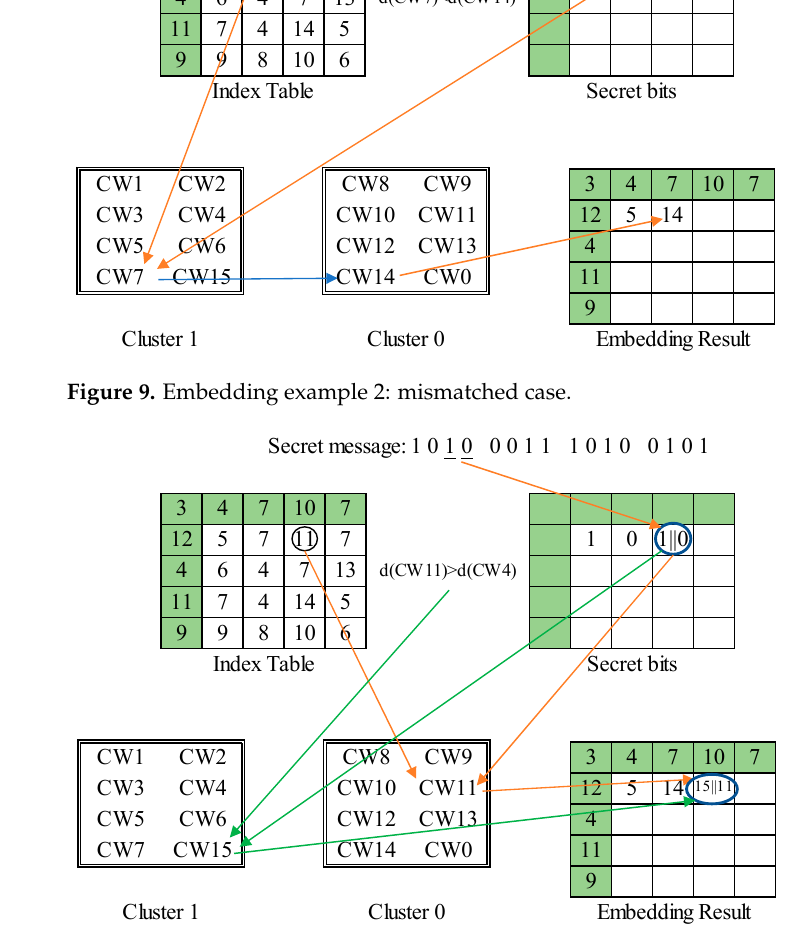
Figure 10. Embedding example 3: abnormal block.